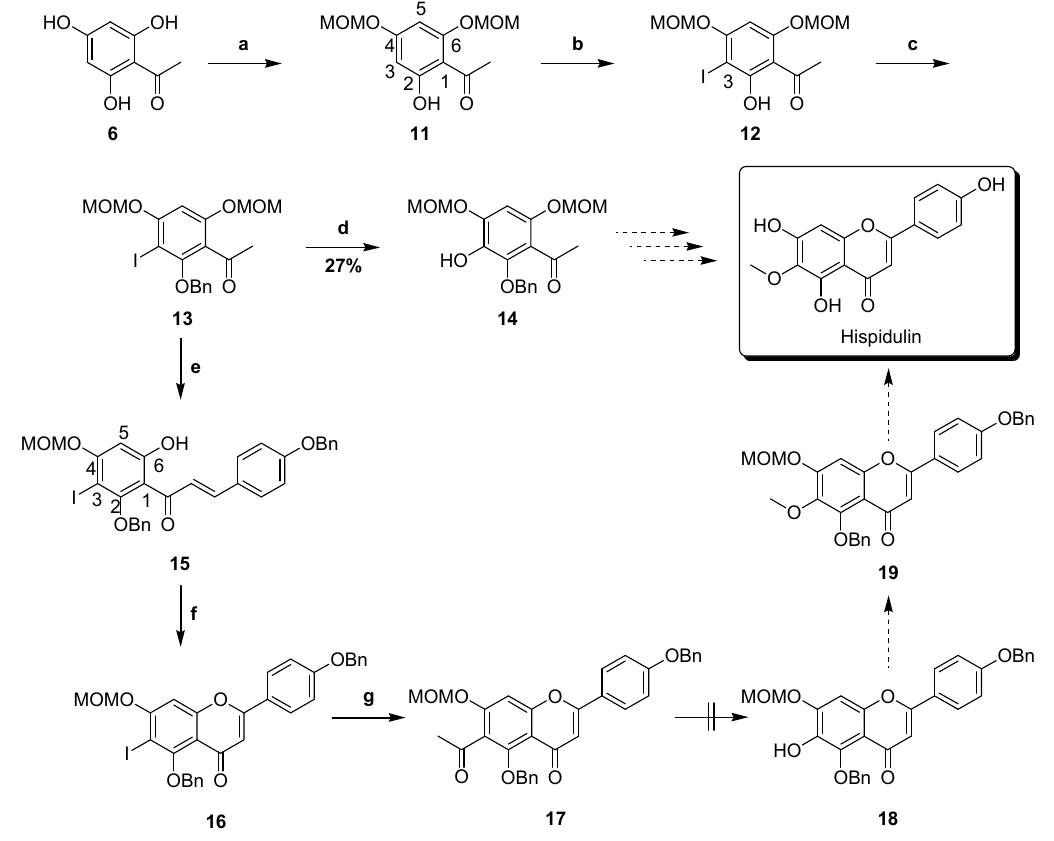
Scheme 4. Initial attempt for the synthesis of hispidulin. Reagents and conditions : ( a ) MOMCl, DIPEA, CH 2 Cl 2 , 0 °C, 64%; ( b ) CF 3 COOAg, I 2 , CH 2 Cl 2 , 0 °C, 90%; ( c ) K 2 CO 3 , BnBr, DMF, 0 °C, 99%; ( d ) Pd 2 dba 3 , t BuXPhos, KOH, dioxane–H 2 O, 90 °C, 27%; ( e ) (1) BnOPhCHO, KOH, EtOH, H 2 O, 0 °C; (2) c-HCl, MeOH, THF, 0 °C, 77%; ( f ) I 2 , DMSO, 120 °C, 32%; ( g ) tributyl(1-ethoxyvinyl)tin, Pd(PPh 3 ) 4 ,